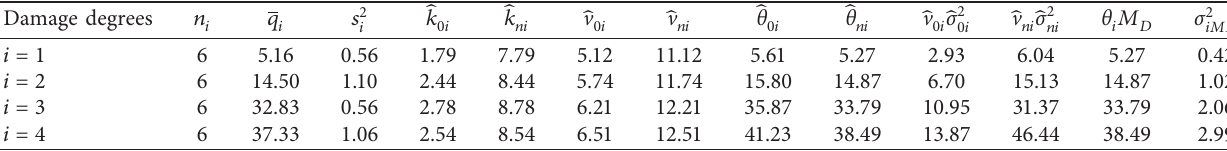
Table 6: Bayesian research